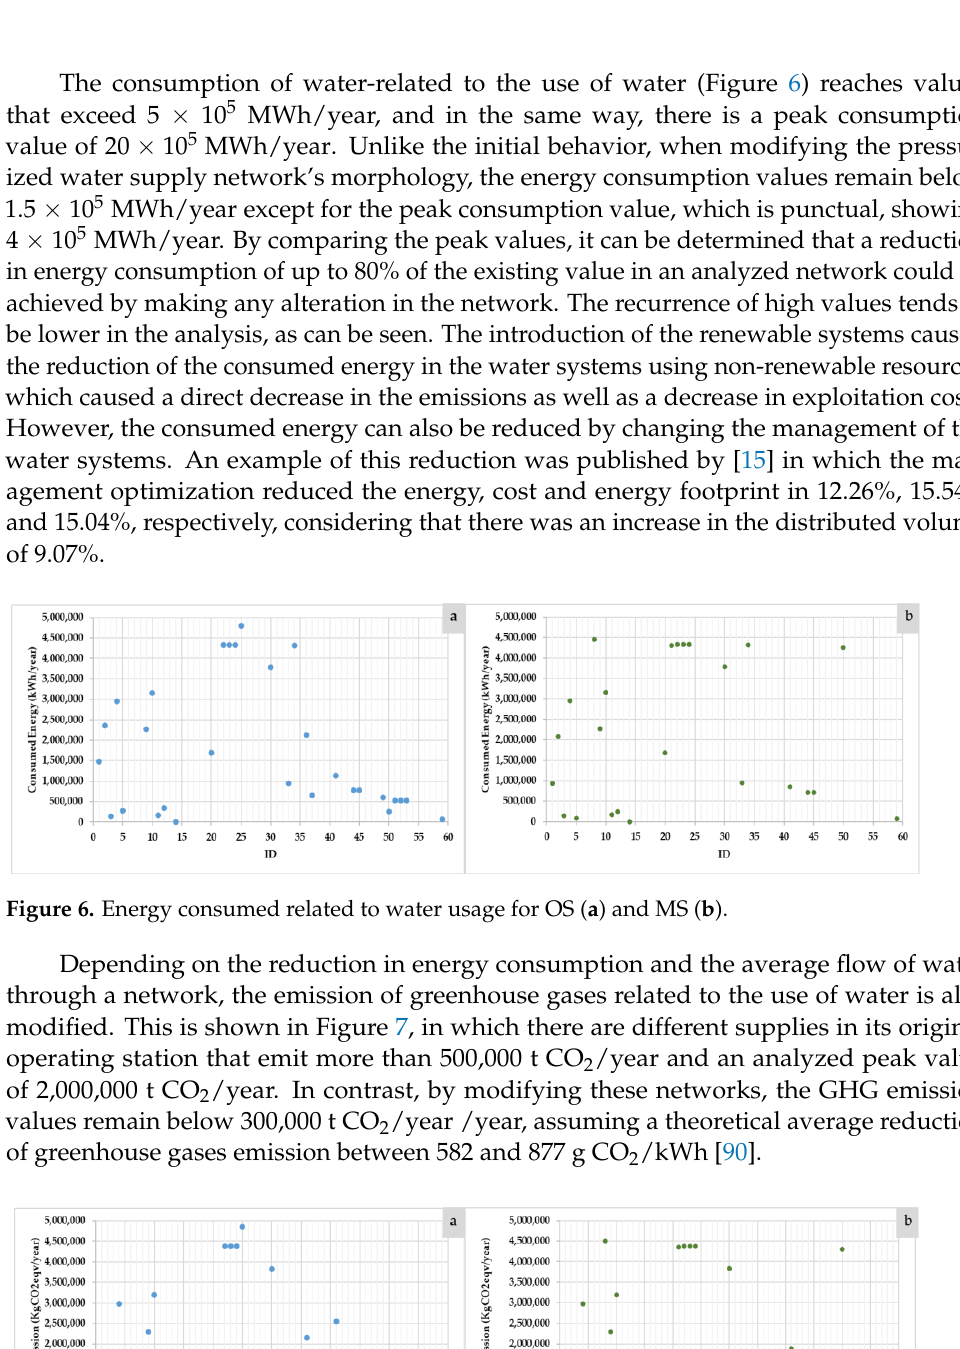
Figure 7. GHG emission related to water usage for OS ( a ) and MS ( b ). However, the development of water pressurized systems supported with the intro- duction of renewable systems, which reduced the dependency of energy consumption of the other non-renewable resources (i.e., coal or gas), improves other environmental indi- cators. Renewable systems have a high social impact on the population, and they promote advantages, which are independent of the payback of the facilities. In developing coun- tries, the use of these systems opens the possibility of supplying consumers with both